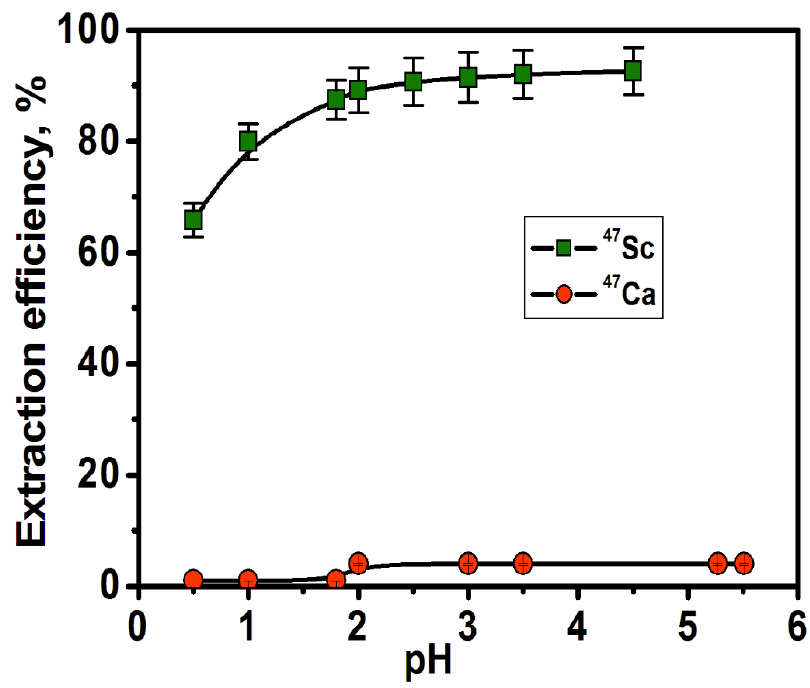
Figure 2. Effect of initial pH on the extraction efficiency (%) of 47 Sc and 47 Ca at a 1:1 phase ratio, with 0.025 M Cyanex 272, an extraction time of 30 min, and at 25 ± 1 °C. Table 1. Distribution ratio values ( D (Sc)/D (Ca) ) and separation factors ( SF ) of 47 Sc and 47 Ca ions